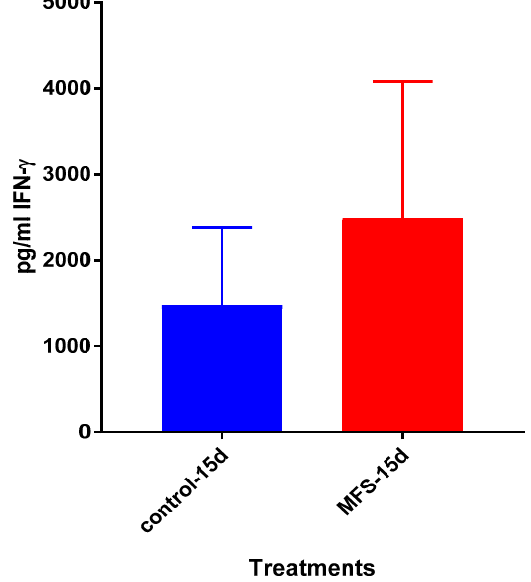
Figure 10. Assay of IFN- γ in the supernatants from untreated and MFS-treated granulomas from healthy subjects. Assay of IFN- γ was performed using an ELISA Ready-Set-Go kit from eBioscience. Data represent means ± SE from eight healthy individuals.